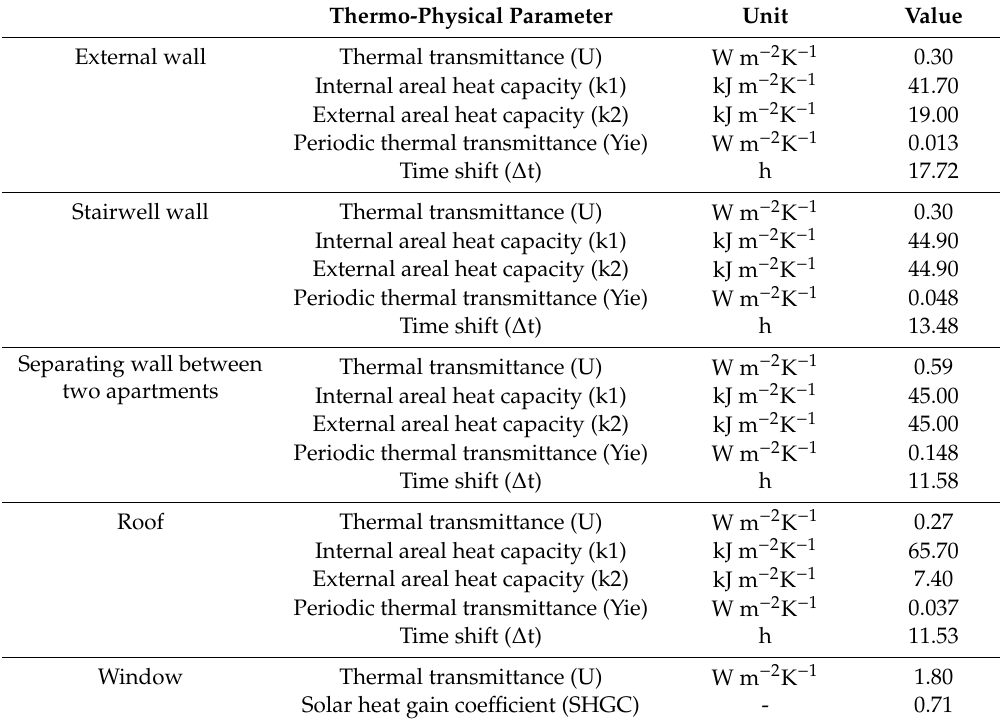
Table 2. Thermo-physical parameters of building envelope elements.